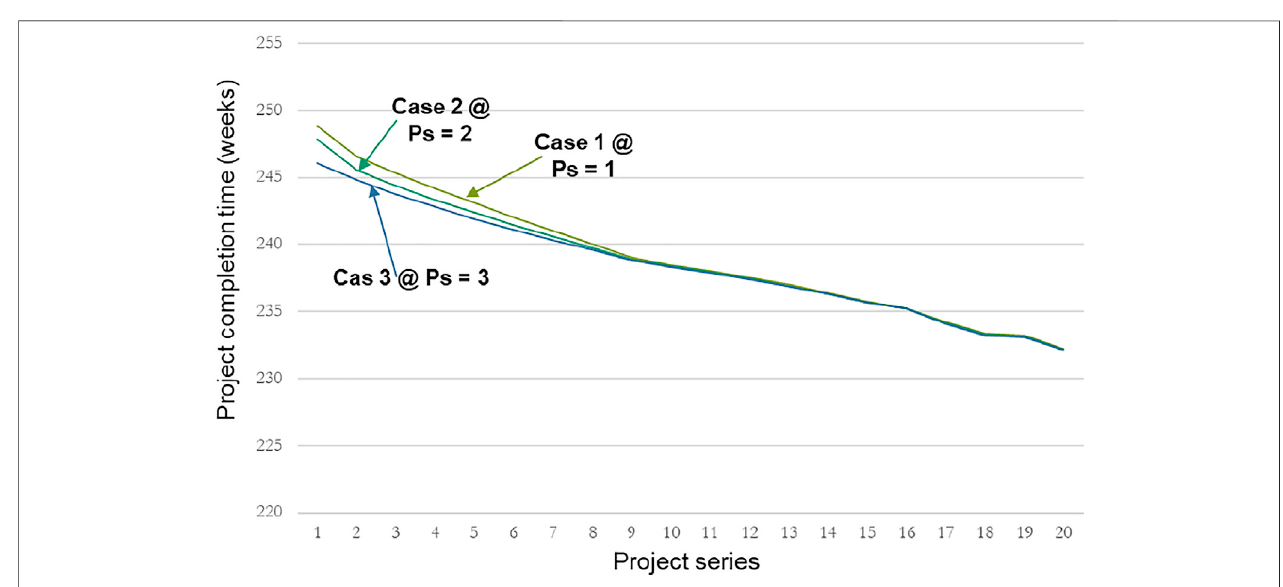
FIGURE 8 | Impact of supervision on project completion